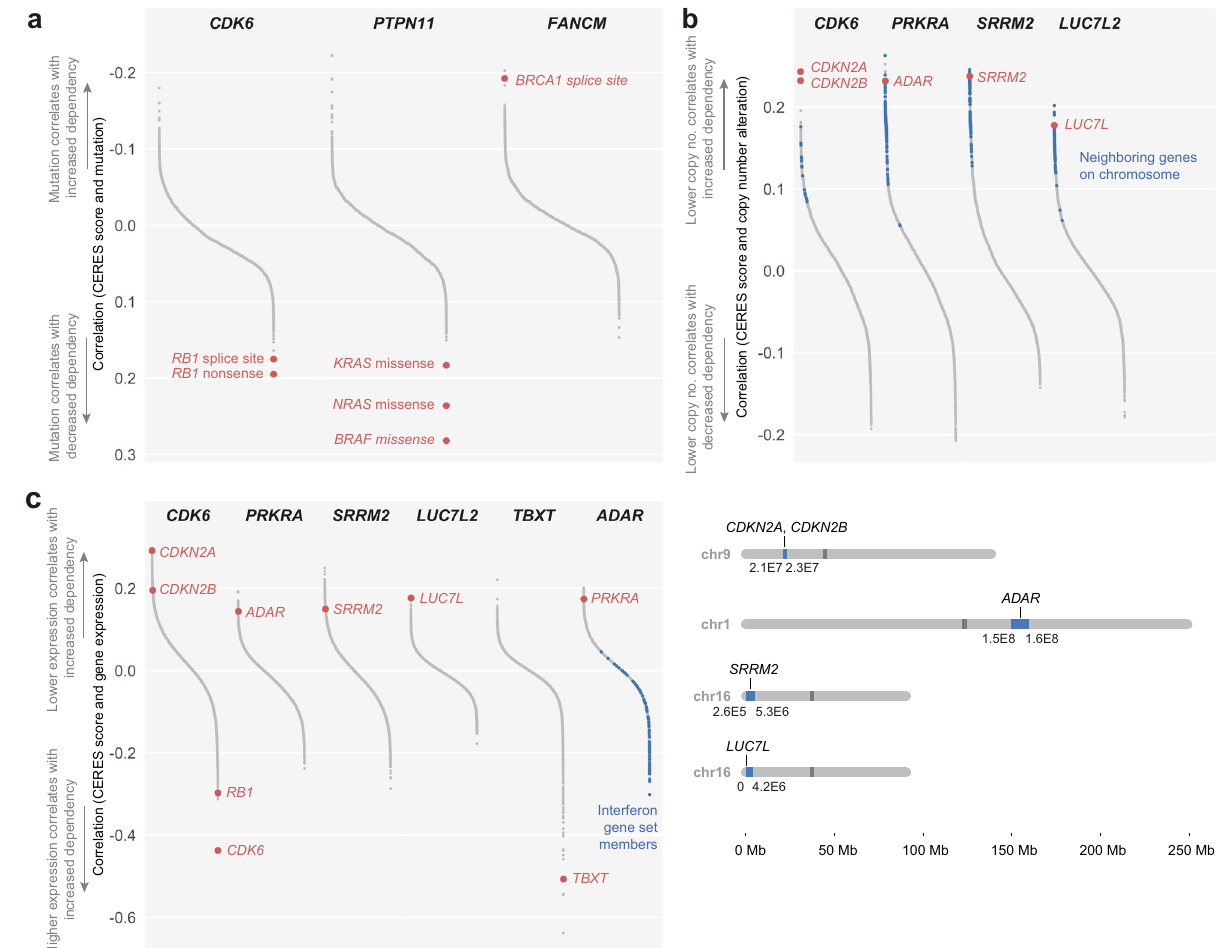
Fig. 3 | Genomic and transcriptomic predictors of gene dependencies. a Mutation correlates of selected dependency genes, ranked by increasing corre- lation coef fi cients. The direction of the y-axis was reversed to maintain consistent interpretation across all panels. b (Top) Copy-number correlates of selected dependency genes, ranked by decreasing correlation coef fi cients. Blue: genes neighboring the labeled correlate on the same chromosome, within a window selected for maximum enrichment of neighboring genes at the top of the corre- lation rank list (see Methods). (Bottom) Genomic loci of copy-number correlates and,inblue,windowselectedbyenrichmentanalysis. c Gene-expressioncorrelates